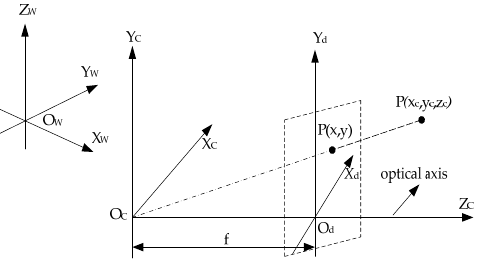
Figure 2. Camera imaging model for visual platform calibration.